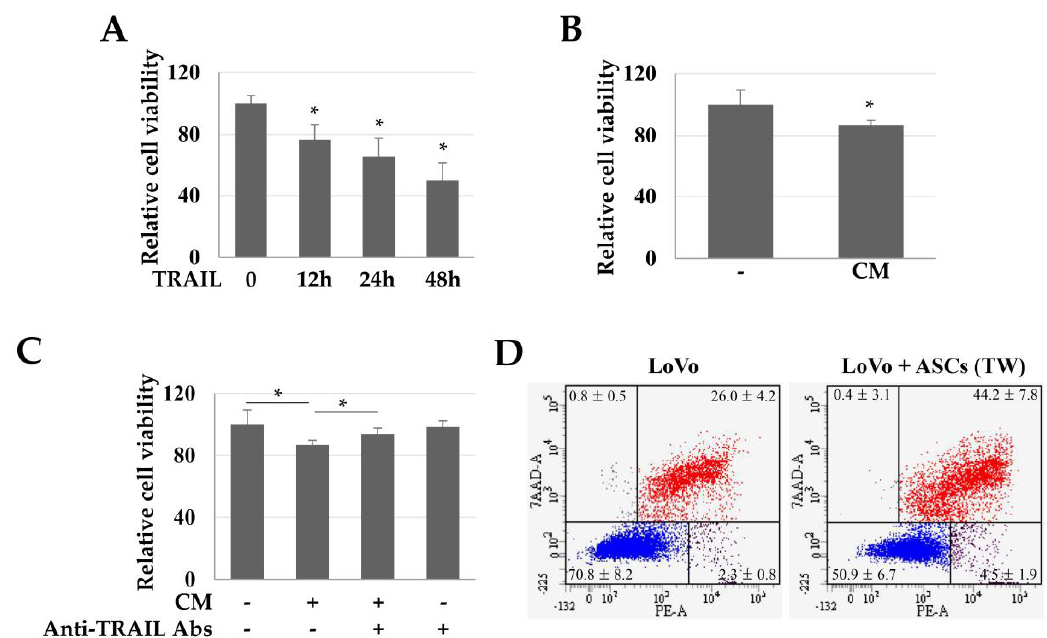
Figure 2. Toxicity of TRAIL and conditioned medium (CM) in LoVo cells. LoVo cells were treated with human recombinant TRAIL or CM and indirectly co-cultured with ASCs. ( A ) Toxicity of LoVo cells by TRAIL at different times. Cell viability decreased in a time-dependent manner. Data are presented as the mean ± SE of three independent experiments. * p < 0.05. ( B ) Relative viability of LoVo cells. LoVo cells were treated with CM for 24 h and toxicity was detected using a WST-1 reagent. * p < 0.05. ( C ) TRAIL-dependent toxicity of CM in LoVo cells. To detect whether the toxicity of CM in LoVo cells was TRAIL-dependent, the TRAIL protein in CM was neutralized with anti-TRAIL antibodies and the cytotoxicity was evaluated using a WST-1 reagent. * p < 0.05. ( D ) ASC-induced apoptosis of LoVo cells. To investigate the direct effects of ASCs on the apoptosis of LoVo cells, the LoVo cells were co-cultured with ASCs and then analyzed by Annexin-V/7-AAD staining and flow cytometry.